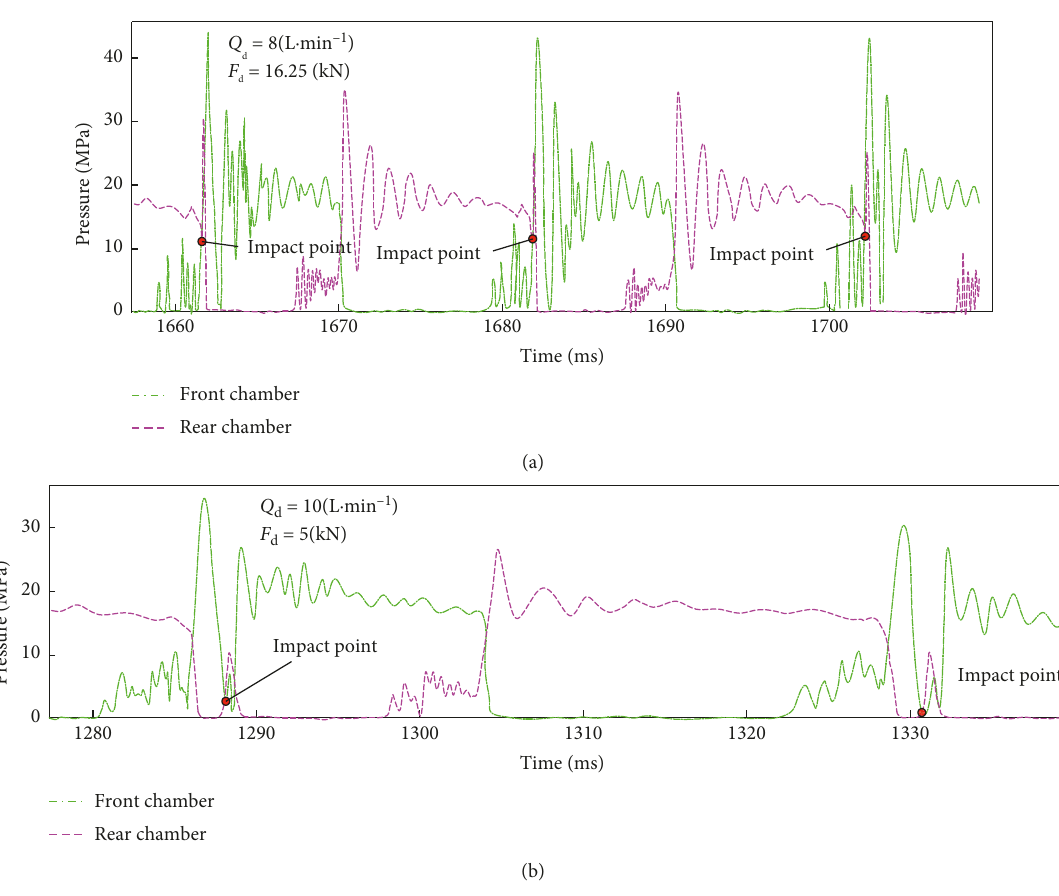
Figure 11: The pressure curves of front and rear chambers of the impact piston under different combinations ( Q